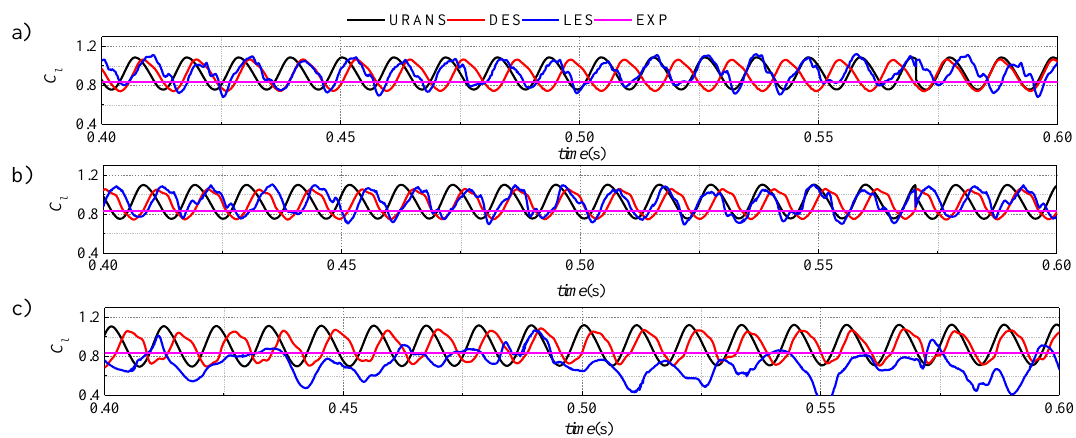
Figure 4. Convergence history of lift coefficient: ( a ) Mesh 1, ( b ) Mesh 2, and ( c ) Mesh 3. URANS represents the results of unsteady Reynolds average Navier-Stokes method; DES represents the results of detached eddy simulation method; LES represents the results of large eddy simulation method; EXP represents the results of experimental.